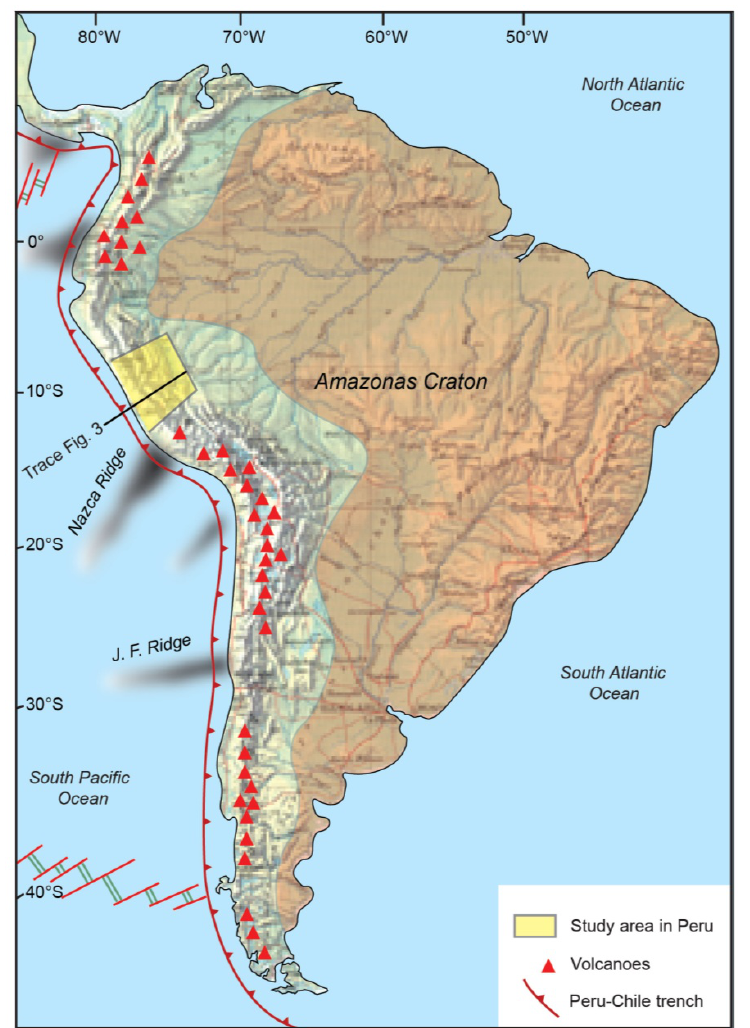
Figure 1. Topographic overview map of South America showing the distribution of volcanoes within the Andes, the plate boundary, the ridges within the Pacific Ocean and the study area in the Central Andes of